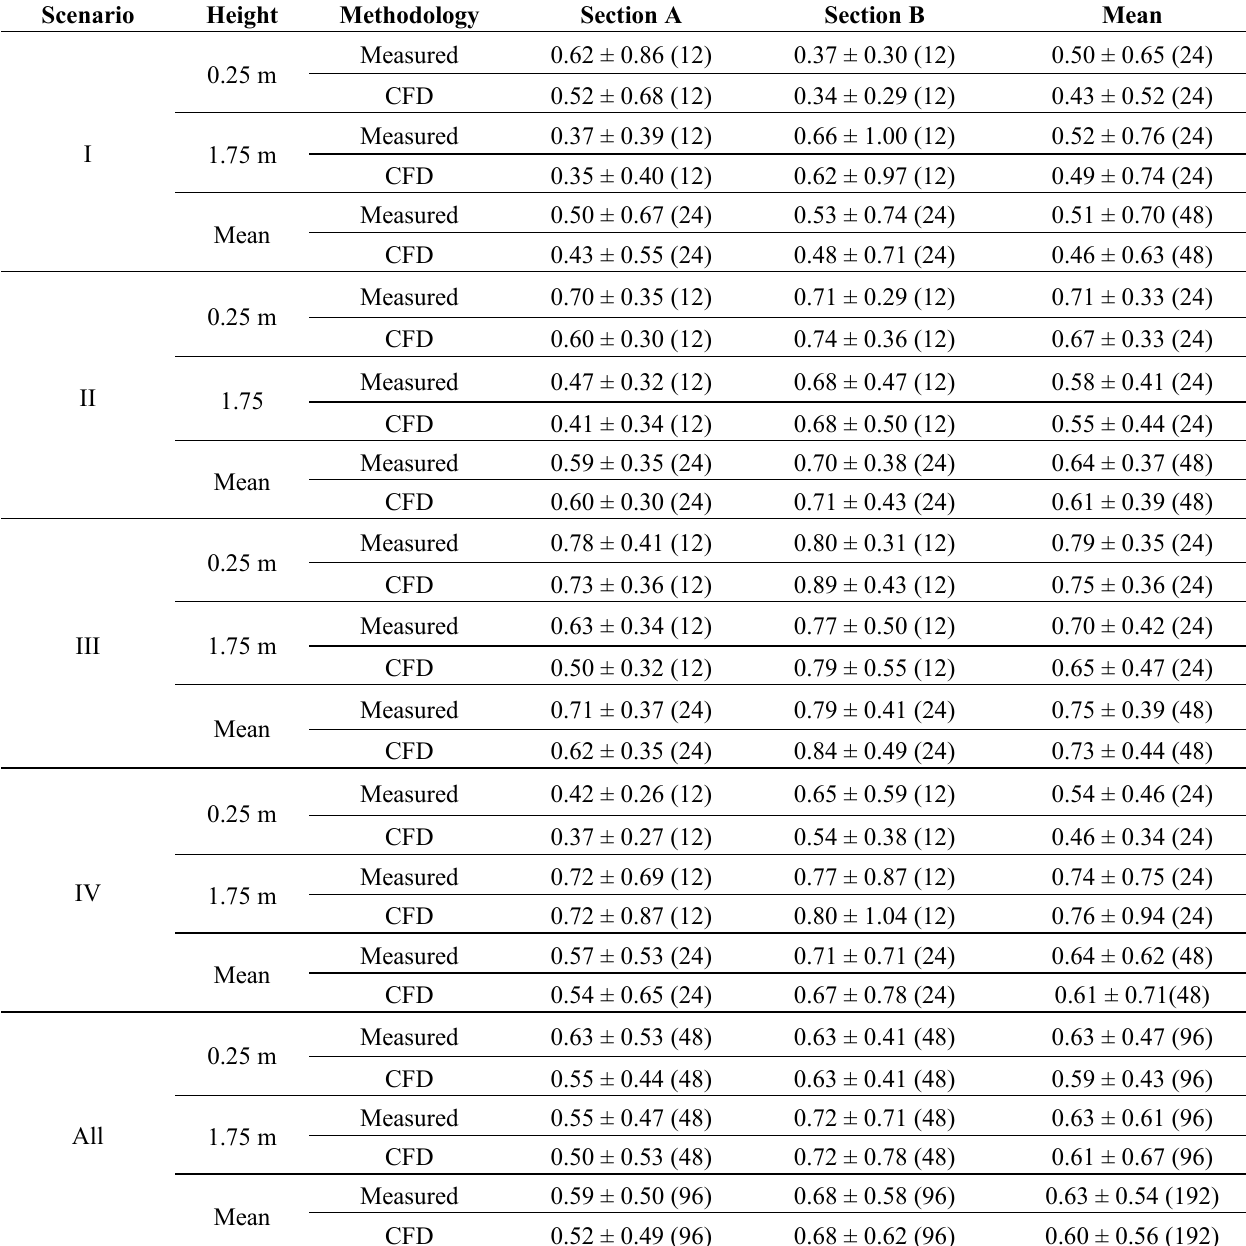
Table 3. Air velocity in m s − 1 (mean ± standard deviation) in the field experiment by direct measurements and by CFD simulations. The number of data is indicated in